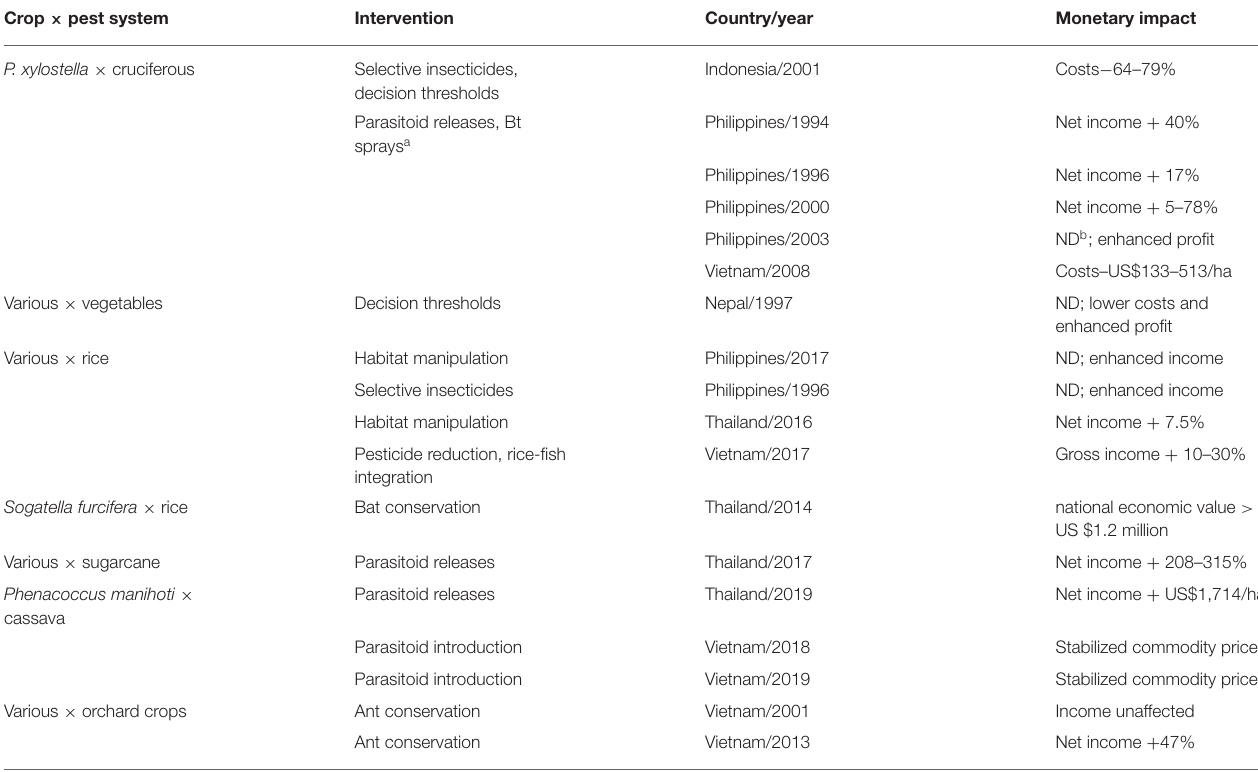
TABLE 2 | Concrete monetary impacts of historic biological control